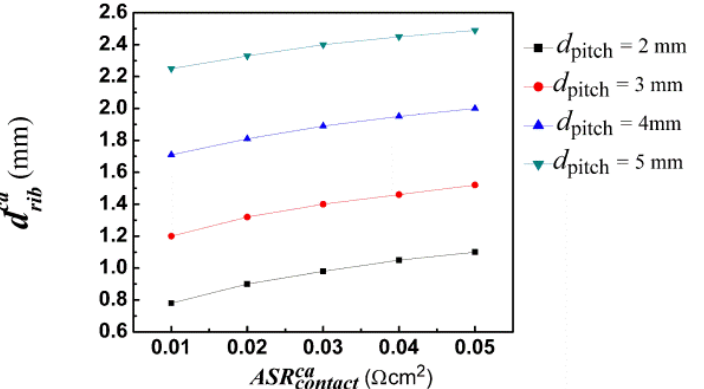
Figure 6. Dependence of the optimal cathode rib width on the contact resistance and pitch